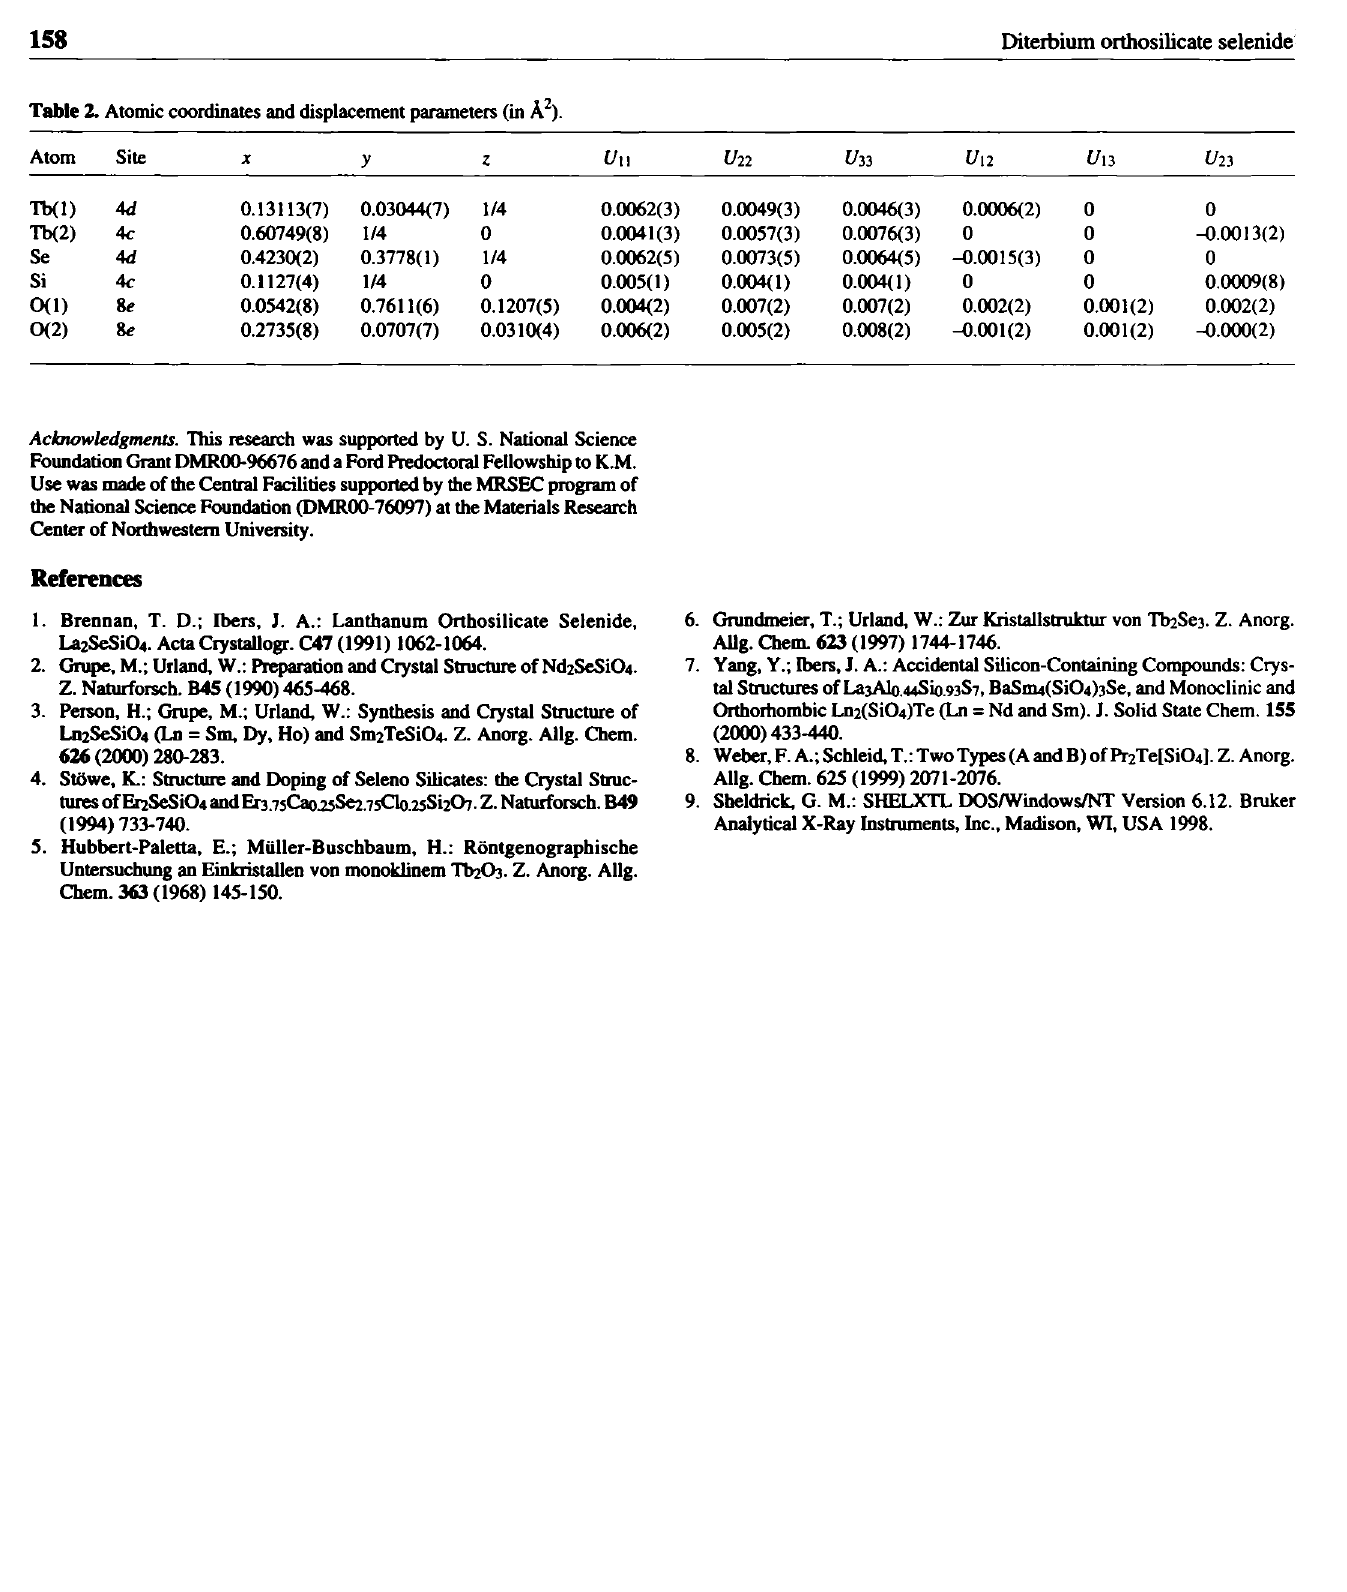
Table 2. Atomic coordinates and displacement parameters (in Â 2